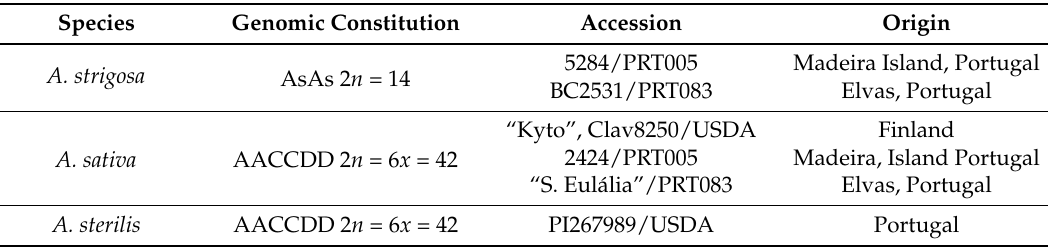
Table 3. Description of Avena accessions analyzed.